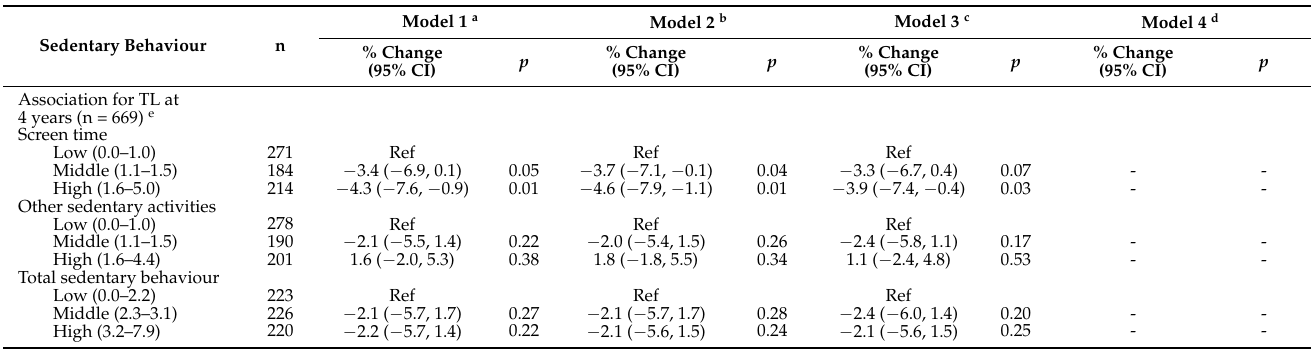
Table 2. Association between sedentary behaviour in tertiles (h/day) and telomere length at the age of 4 and changes in telomere ranking from 4 to 8